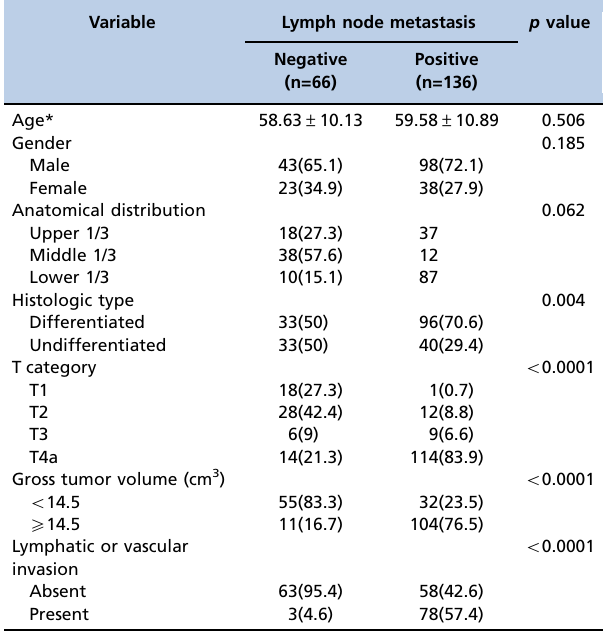
Table 1 - Univariate analysis of clinicopathological factors and gross tumor volume correlated with regional lymph node